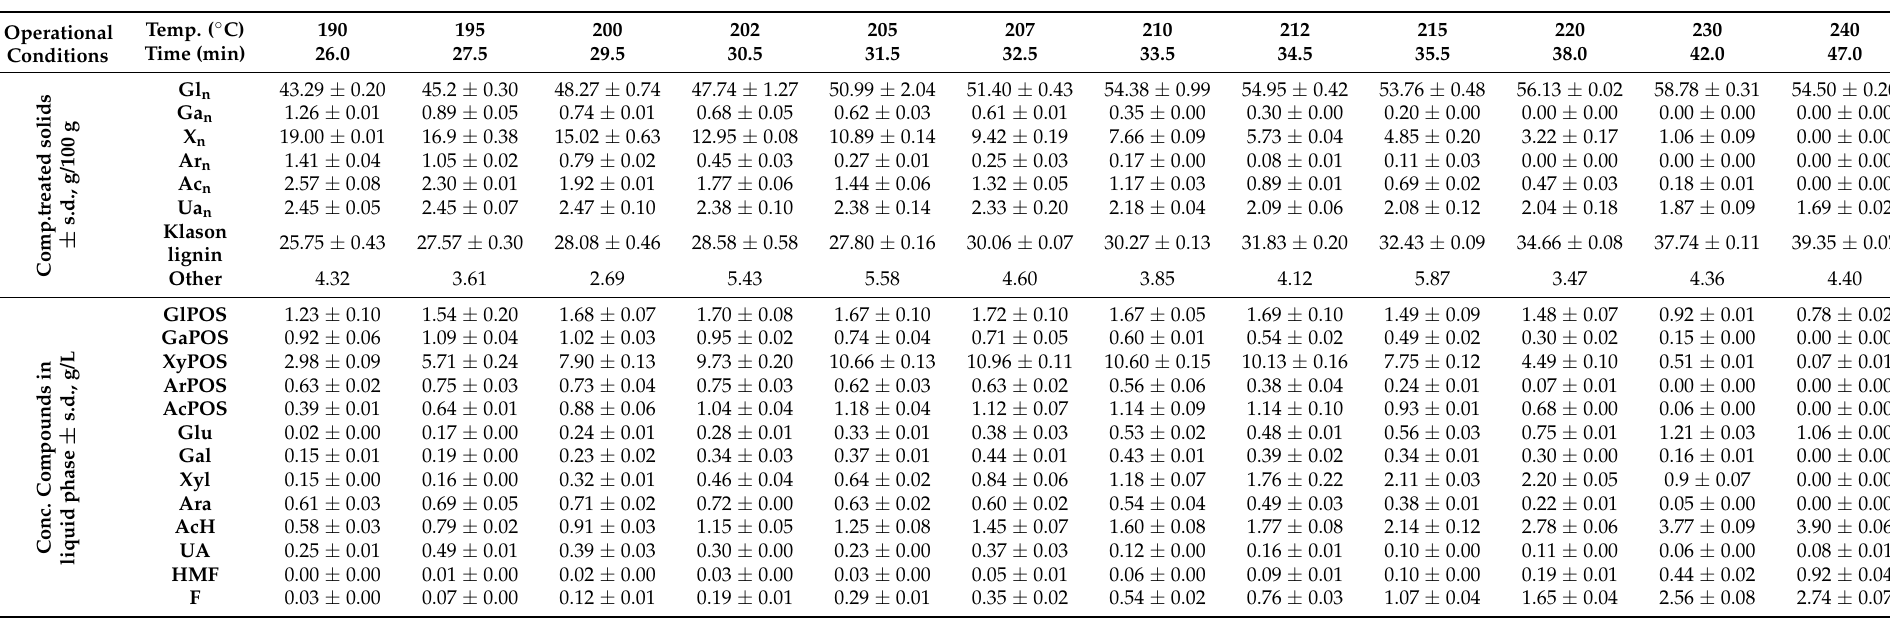
Table 3. Operational conditions considered in this study, compositions of the treated solids, and concentrations of the liquid phases (measured in g/L). Operational